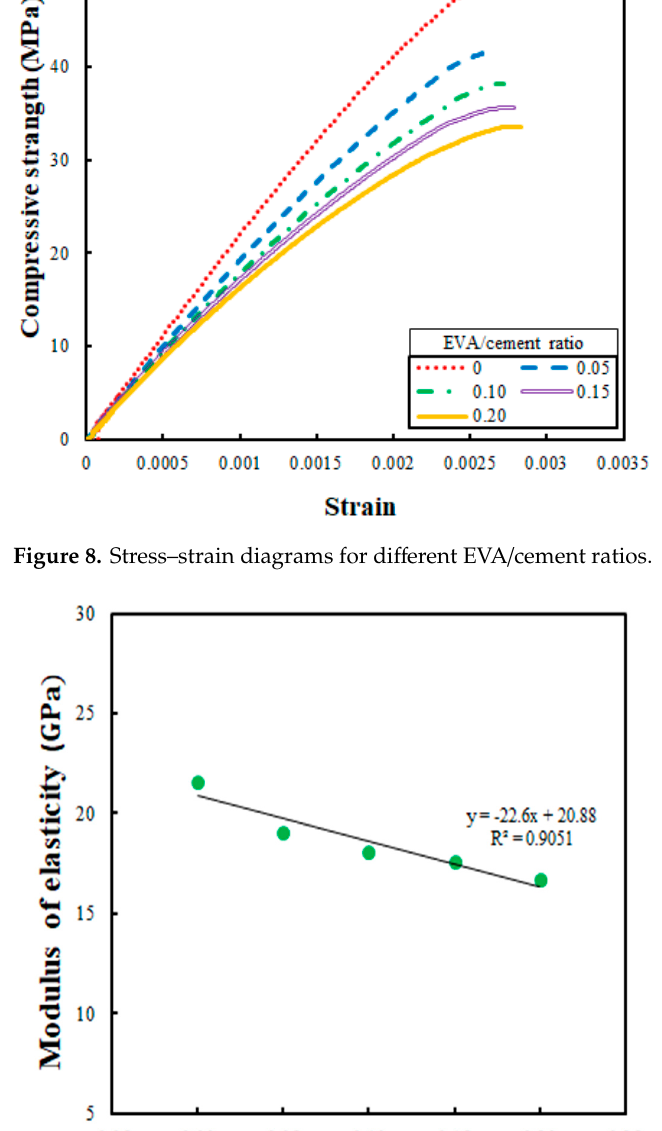
Figure 10. Relationship between the compressive strength and modulus of elasticity. 4.2. Drying Shrinkage Drying shrinkage is one of the major causes of cracking in concrete. Once exposed to air, concrete starts to dry out and the dried surface contracts. The internal moisture, however, suppresses shrinkage in the outer part. Accordingly, the surface regions undergo tensile stresses, and when the stress-induced drying shrinkage exceeds the direct tensile strength of the concrete, cracking occurs. One advantage of 3DCP is that formwork is not necessary. This removes a barrier between the curing concrete and ambient environment. Printed layers often have a greater exposed surface area than cast concrete. However, lower water/cement ratios than those seen in casting concrete are typical in 3DCP mortars. Hence, the likelihood of cracking resulting from autogenous shrinkage is increased. Therefore, mix designs must minimize dimensional changes due to dry and autogenous shrinkage and greater care should be taken when curing [25].